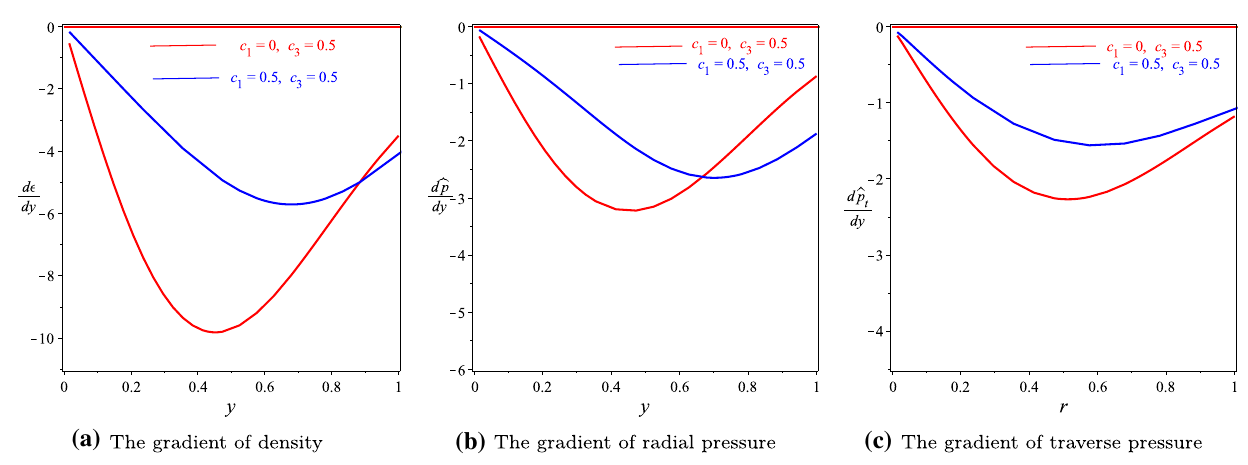
Fig. 3 The gradient of density, radial and transverse pressures when c 1 = 0 and c 1 = 0 .